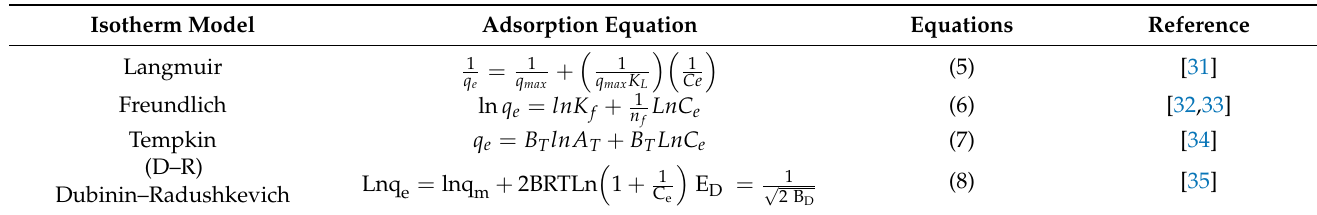
Table 1. Isotherm model